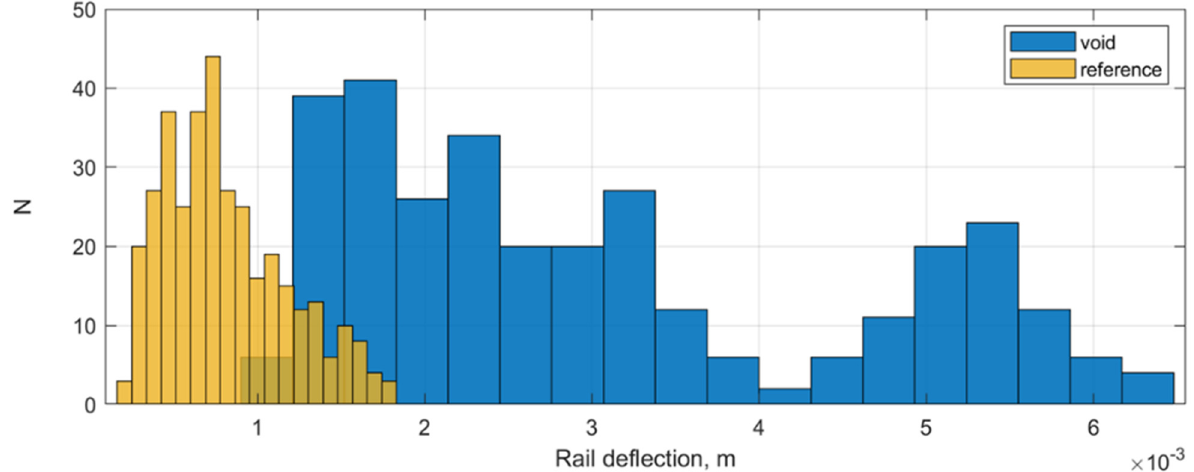
Figure 17. The distribution of rail deflection in the voided and reference zone.